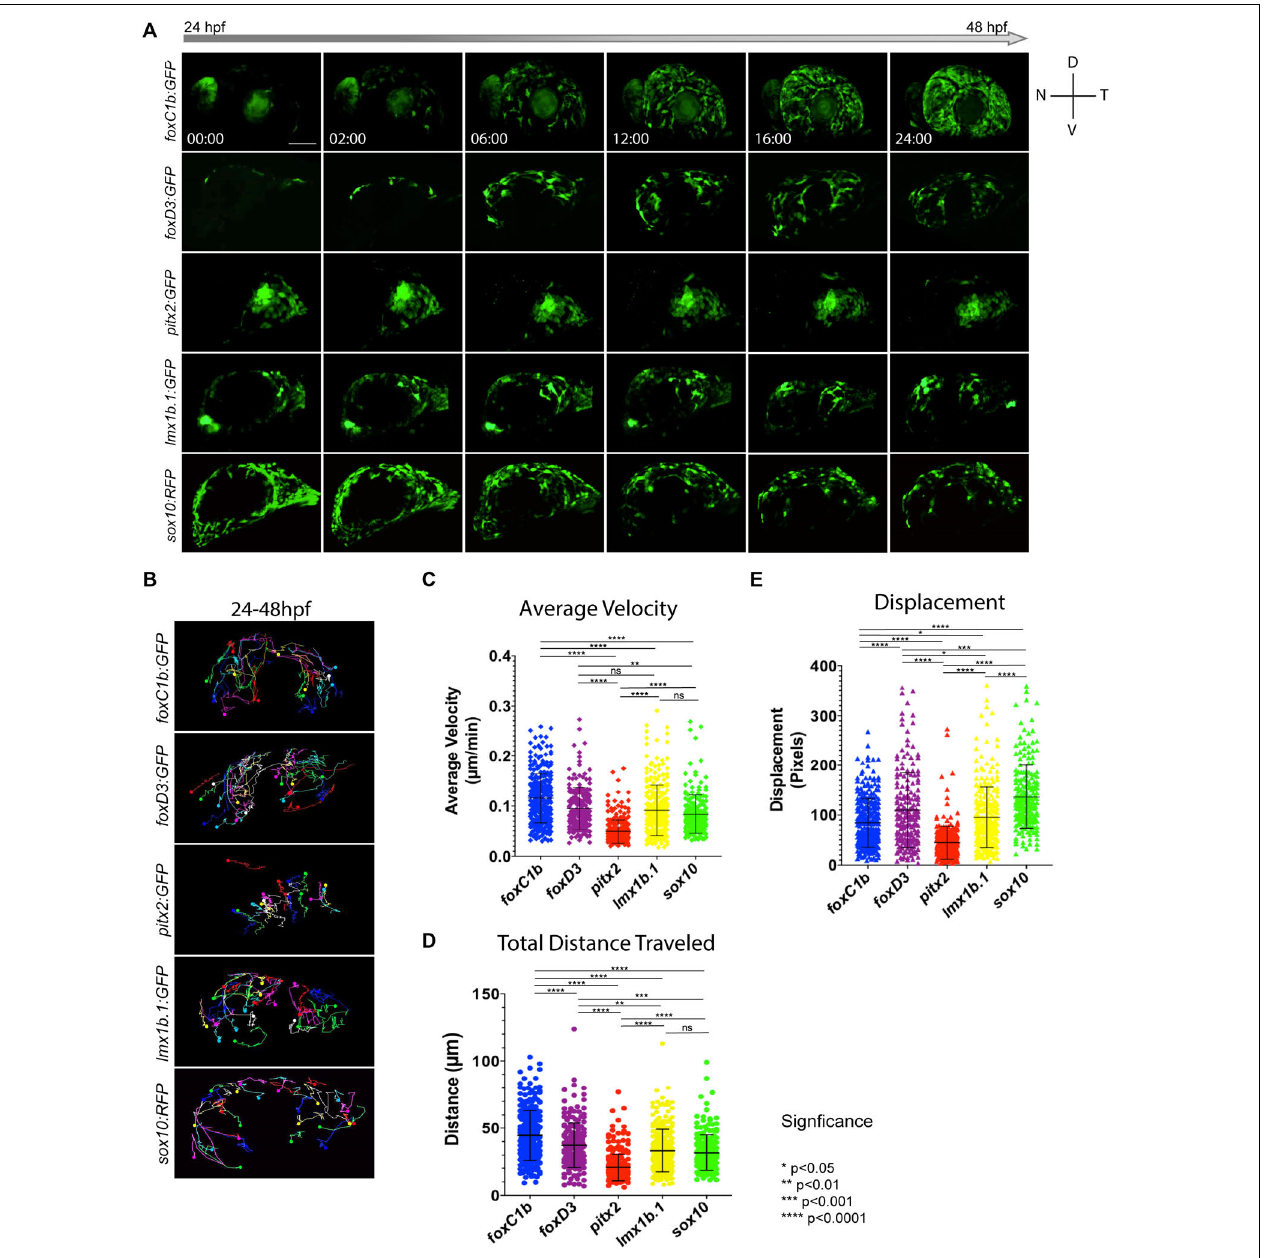
FIGURE 4 | In vivo 4D imaging of POM anterior segment colonization. (A) 4D in vivo imaging of the AS conducted between 24–48 hpf using POM transgenic lines. Time stamp hours:minutes. Scale bar = 50 µ m. (B) Individual cell tracking for each POM transgenic line reveals migratory patterns during early AS colonization. Solid spheres indicate terminal end of track. (C–E) Cell tracking measurements of average migratory velocity (ANOVA p < 0.0001), total migration distance (ANOVA p < 0.0001), and migratory displacement within the AS (ANOVA p < 0.0001).